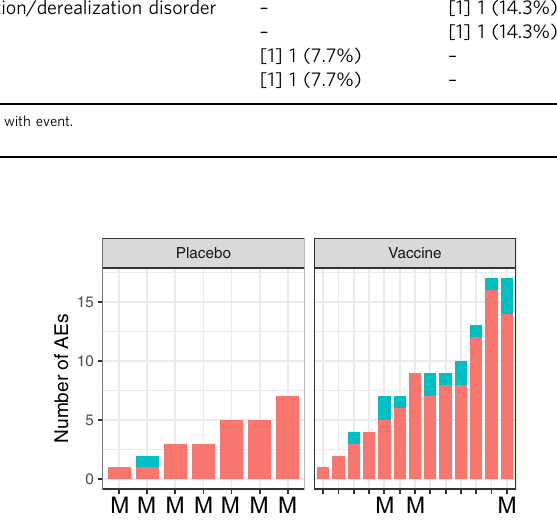
Fig. 6 The number of adverse events (AEs) during the immunization period in the placebo and vaccine groups. Each bar represents one volunteer sorted on the number of AEs from the time of fi rst injection with normal saline or PfSPZ Challenge until the end of the vaccination period. Mild (grade 1) AEs are depicted in red, moderate (grade 2) in turquoise. Non-protected volunteers are marked with an “ M ” on the x IgG one day before CHMI showed that median PfCSP-speci fi c IgG was 10-fold higher in protected (127 µg/ml, 95% con fi dence interval (CI): 36 – 231 µg/ml) than in unprotected vaccinees (18 µg/ml, 95% CI: 6 – 33 µg/ml). Median levels of IgM antibodies to PfCSP 2 weeks after the third dose and 1 day before challenge were 6.7 and 2.5 higher in uninfected (protected) vs infected vaccinees, but differences did not reach the level of statistical signi fi cance ( p = 0.112 and 0.119) (Supplementary Fig. 1). IgG antibody responses to PfCSP were in general highest 2 weeks after the third dose and remained elevated through 28 days after CHMI (Supplementary Fig. 2A). IgM response also peaked after